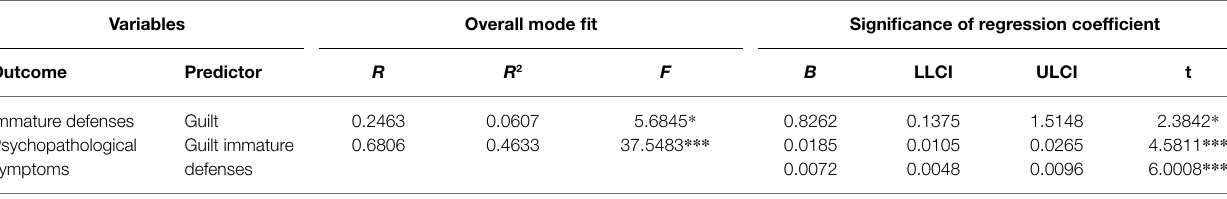
TABLE 3 | Mediation model of the mediating role of immature defenses in the relationship between guilt and psychological distress. Variables